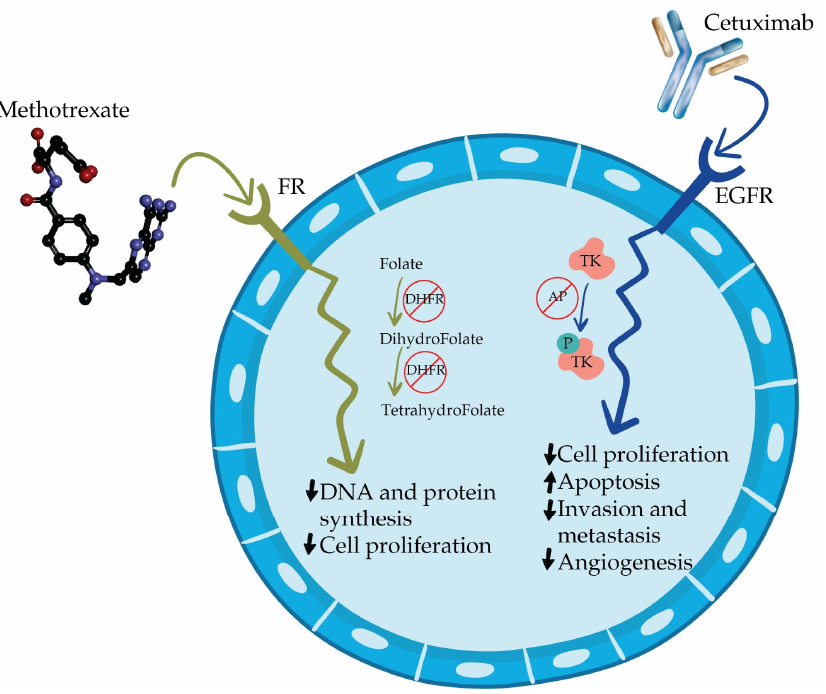
Figure 1. Mechanism of antitumor action of Methotrexate and Cetuximab. Methotrexate is an antagonist of the folate receptor (FR) causing the blockade of the enzyme dihydrofolate reductase (DHFR) having consequently inhibition of protein and DNA synthesis and cell proliferation. Cetuximab acts on the EGFR receptor by inhibiting the autophosphorylation (AP) of tyrosine kinase (TK), thereby terminating the inhibition of cell proliferation, invasion, metastasis, and angiogenesis, while stimulating the process of apoptosis.